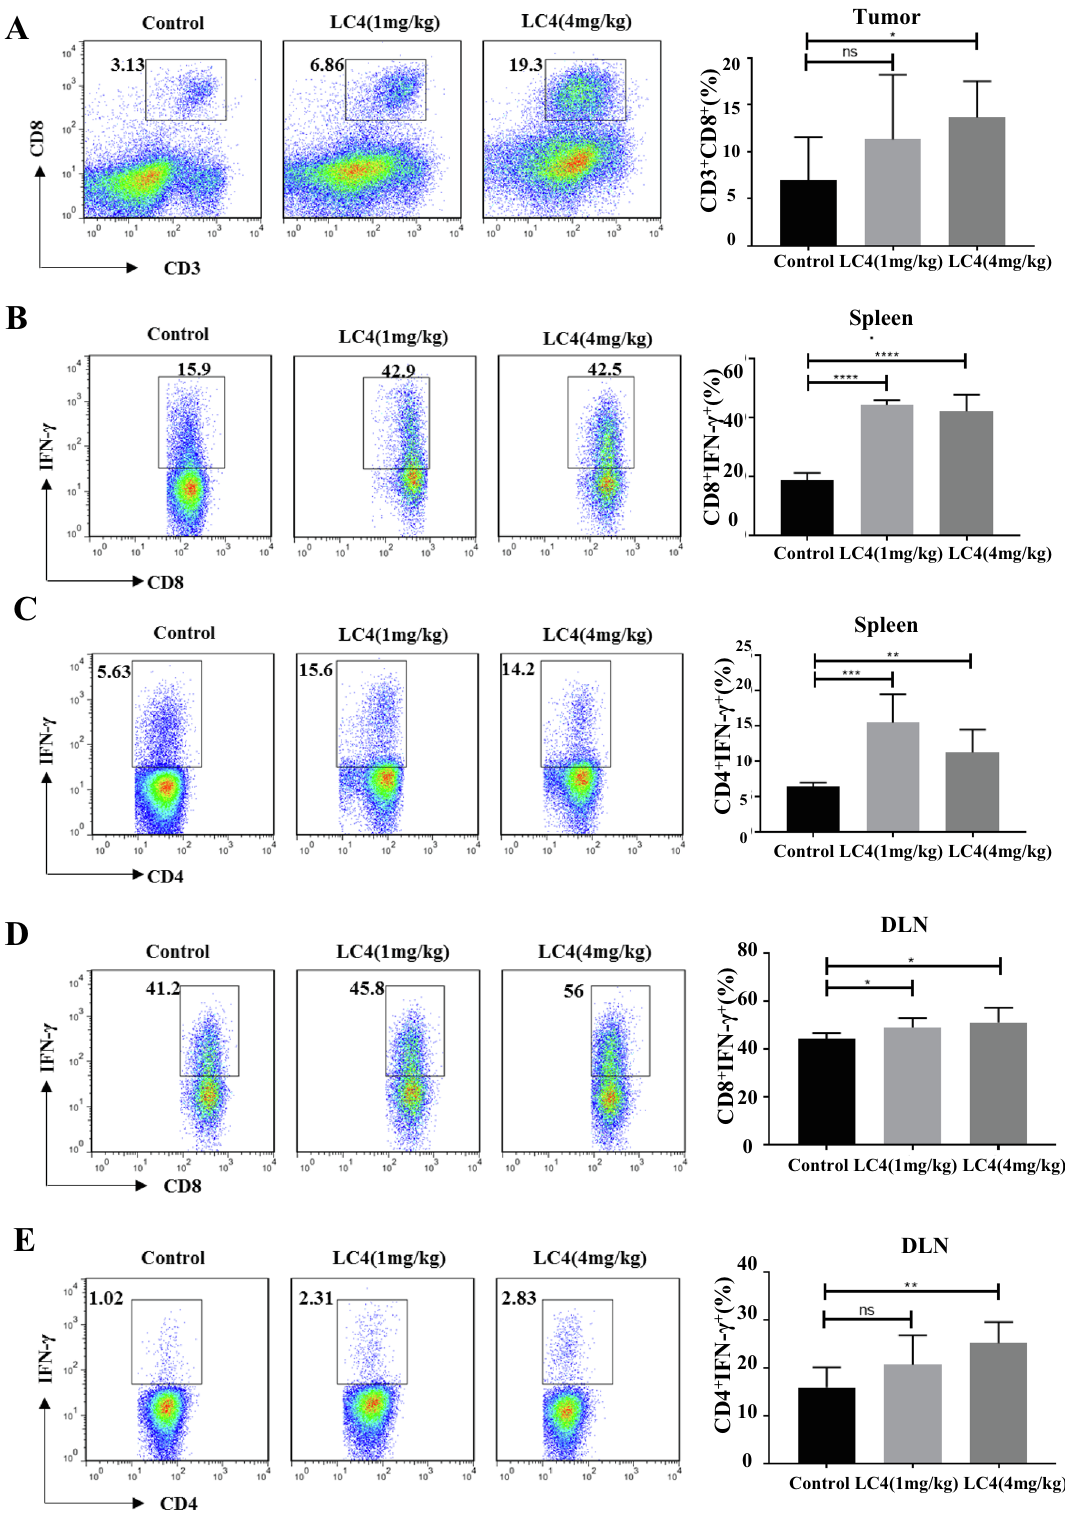
Fig. 6 The LC4 activation on T cells was determined in vivo. Tumour tissues were cut into pieces and digested with collagenase IV and DNase I, and then ground into single cell suspension. PMA and ionomycin stimulated the spleen cells, draining lymph node cells of the tumour-bearing mice. Flow cytometry was used to detect the LC4 effect on T cells in vivo. The percentage of A infiltrating CD 8+ T cells in the tumour, B CD 4+ IFN-γ + T cells in the spleen, C CD 8+ IFN-γ + T cells in the draining lymph nodes, and D CD 4+ IFN-γ + T in the draining lymph nodes. Data are expressed as the mean ± SD (n = 5) and statistical significance between groups was determined by Student’s t test: * p < 0.05, ** p < 0.01, *** p < 0.001, **** p < 0.0001; ns = no signifi-